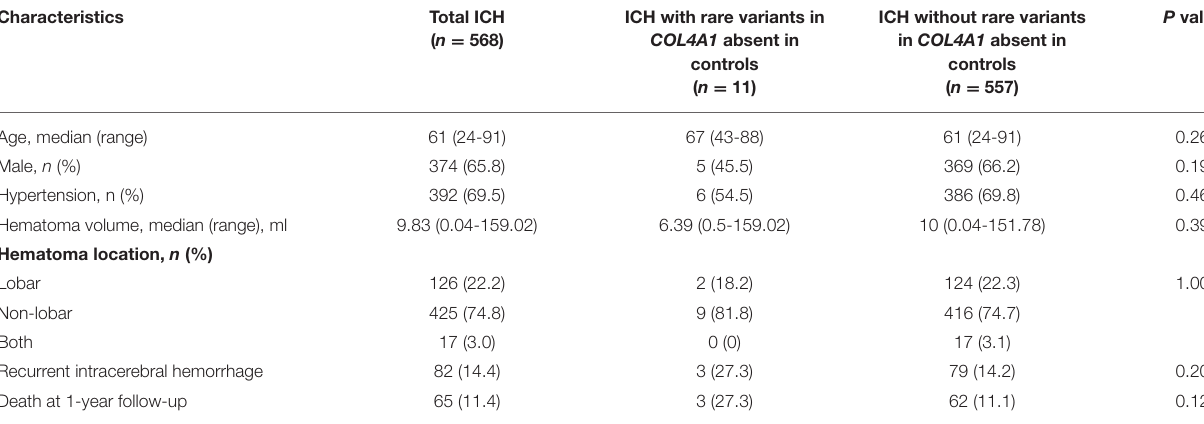
TABLE 1 | Demographic and clinical characteristics of ICH patients. Characteristics Total ICH